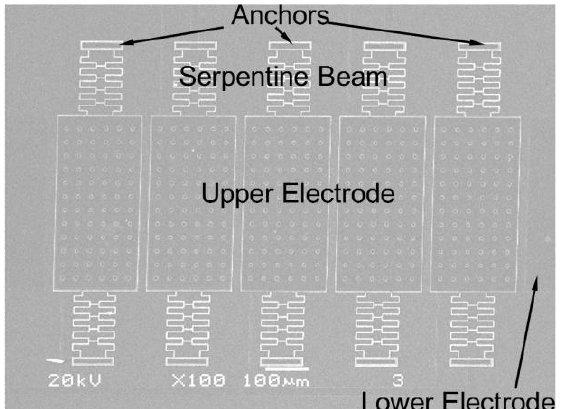
Figure 7. SEM image of the prototype, electron gun voltage was set to be 20 kV, and amplification factor was